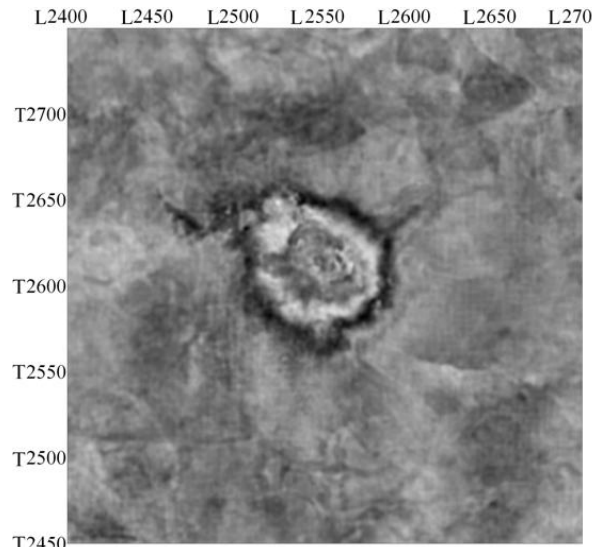
Fig. 11. Seismic time slice at 716 ms in Mapengkou region.